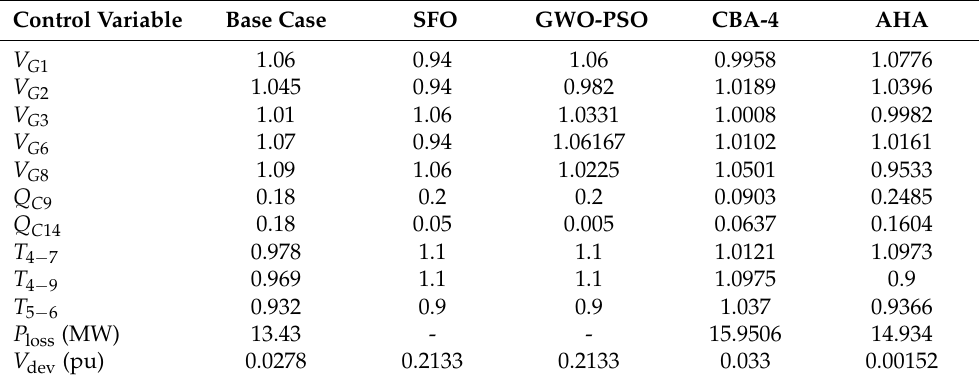
Table 4. Optimal values of control variables with V dev as an objective function for the IEEE 14 bus test